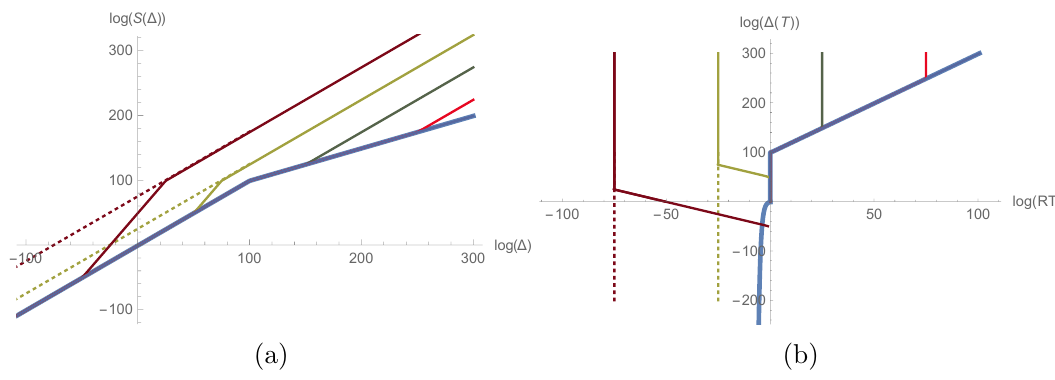
Figure 1 . S ( E ) and E ( T ) for the T ¯ T deformed symmetric product CFT. We actually plot S (∆) and ∆( T ) ≡ R E ( T ) + c 1 N/ 12 in a log-log plot to schematically highlight the scaling feature. We are using ∆( T ) as a convenient parametrization of energy since it is dimensionless and is zero for the vacuum state. Where the entropy scales as S ( E ) ∼ E α , the slope of these lines correspond to α . When the slope is one, the spectrum has Hagedorn density. Where the slope is 1 / 2 , the spectrum is Cardy like. The spectrum is super-Hagedorn and exhibits negative specific heat in the segment where the slope is greater than one. The thick blue line describes the undeformed theory. We have taken µ = R 2 ( c 1 N ) − n/ 2 , or T T ¯ T = ( c 1 N ) n/ 2 − 1 /R , for n taking values − 1 , 1 , 3 , and 5 , corresponding H to the brown, light green, dark green, and red lines, respectively. The strength of T ¯ T deformation increases as one goes from red to brown in the figure. The light green and brown corresponds to